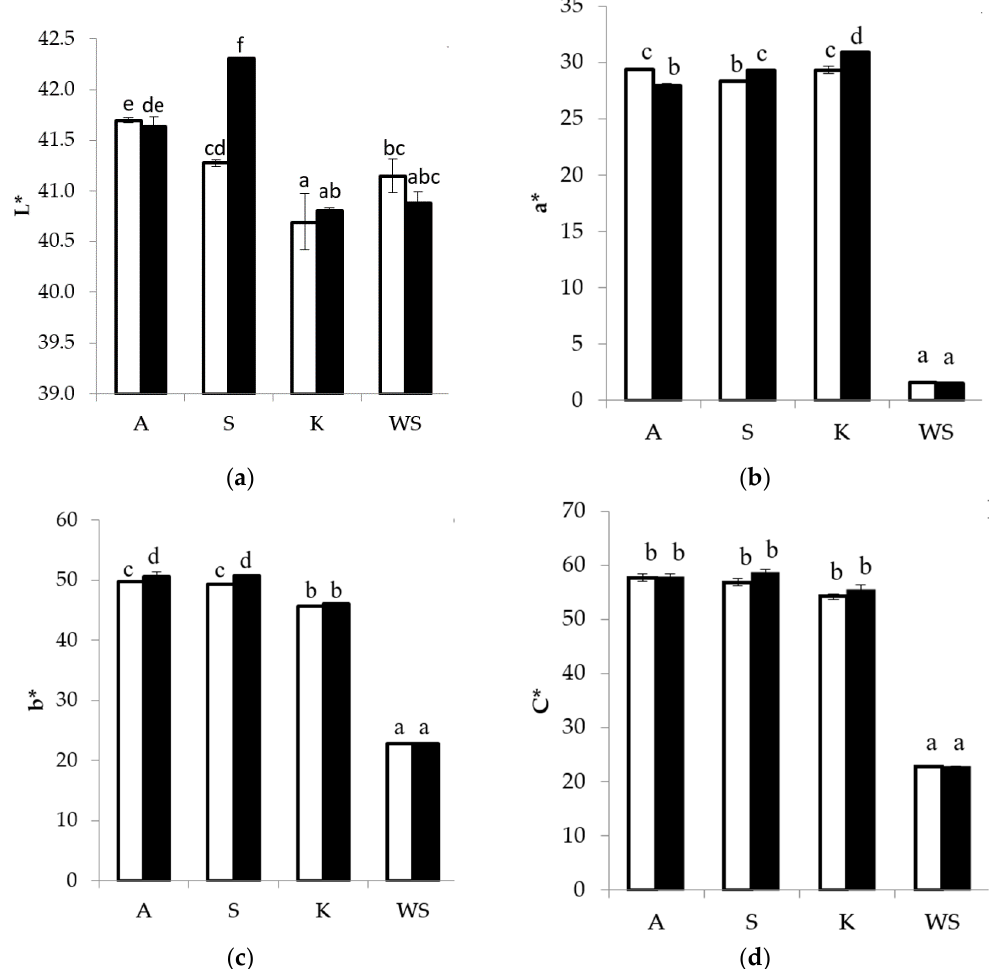
Figure 6. Selected parameters of instrumental color analysis of carrot juices. ( a ) Parameter L*; ( b ) Parameter a*; ( c ) Parameter b*; ( d ) Parameter C*. White bars, CJ and black bars, BCJ. Various types: A, Askona F1; S, Samba F1; K, Kazan F1; WS, White Satin. Mean ± SE, the same letters set no differences at p < 0.05.